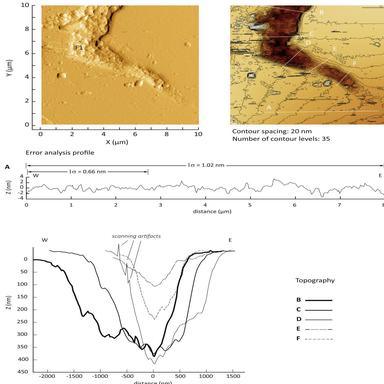
Topographic profiles of the surface of sample RN02. Upper left: Shaded relief AFM image with location of Profile A; upper right: unshaded nDTM with superimposed contours every 20 nm and location of profiles B to F. Profile A shows the corrected topographic measurement of the surface of the sample in an area devoid of structural features used to estimate the error on topographic flatness. On profile A, Z = 0 corresponds to average profile elevation. The other profiles are aligned on top, which is given the v